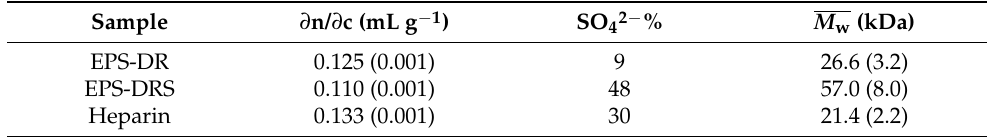
Table 1. Determination of ∂ n/ ∂ c for EPS-DR and -DRS, and heparin in water at 25 ◦ C and the molecular masses (uncertainties between brackets).